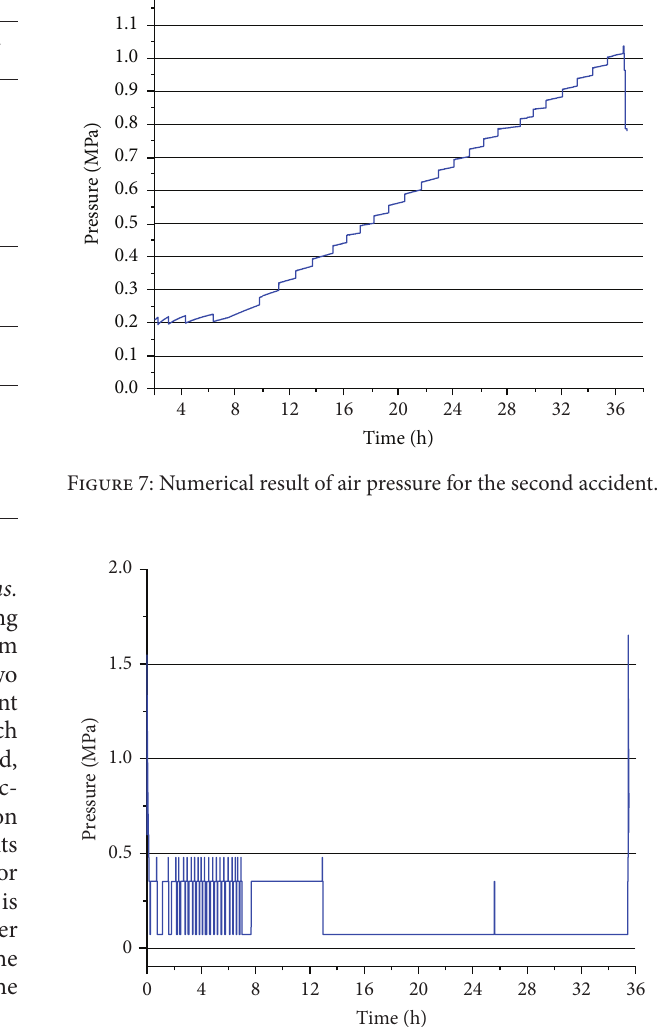
Table 3: Summary of numerical simulation of the two accidents.